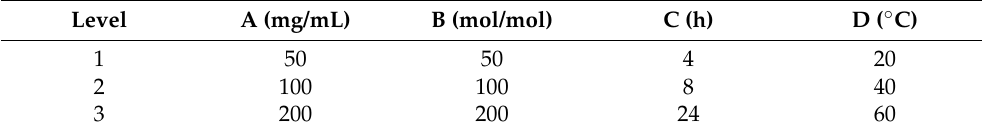
Table 1. Factor-level arrangement